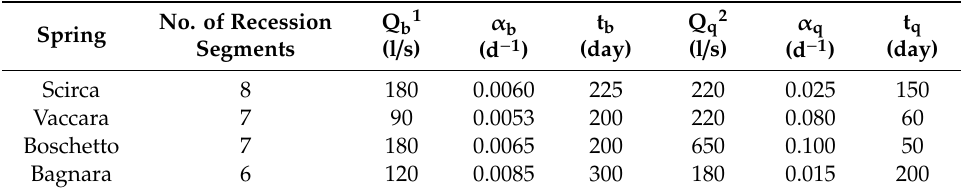
Table 4. Characteristics of recession curves of springs with bimodal behavior and their related sub-regimes (baseflow or quickflow).